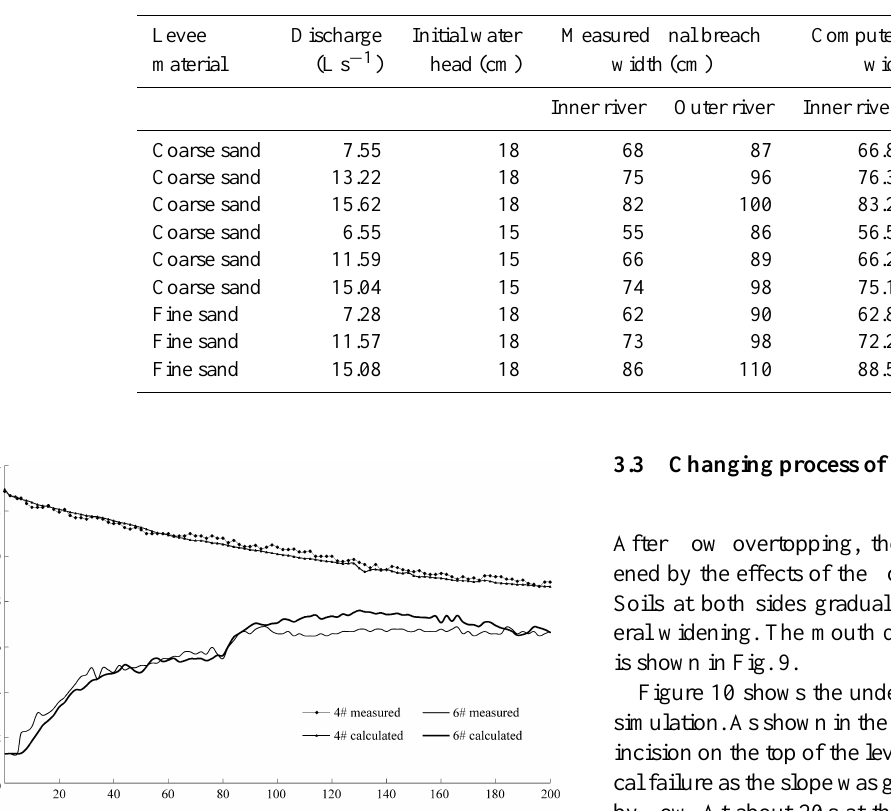
Table 1. Comparison of the computed with measured final breach width.